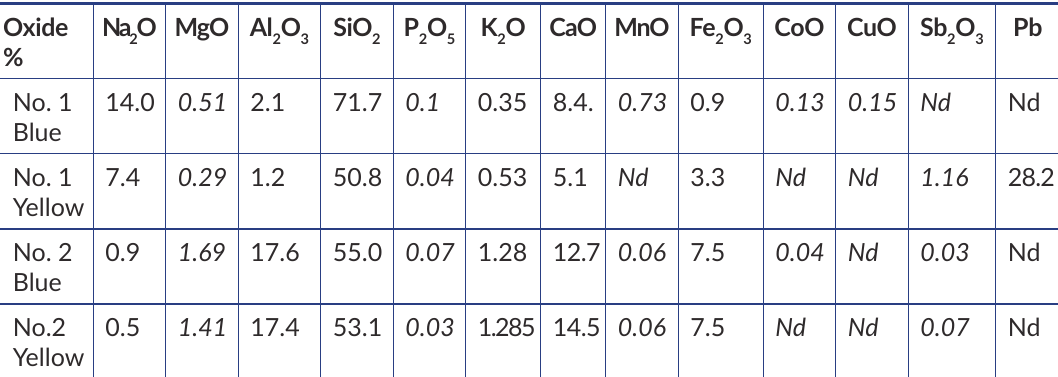
Table 1: Chemical composition (%) of glass beads using EDX. Results from bead. No.2 normalized. WD results for Magnesium, Phosphorus, Potassium, Manganese, Colbate, Copper and antimony shown in italics (after Macdonald and Davis 2002: